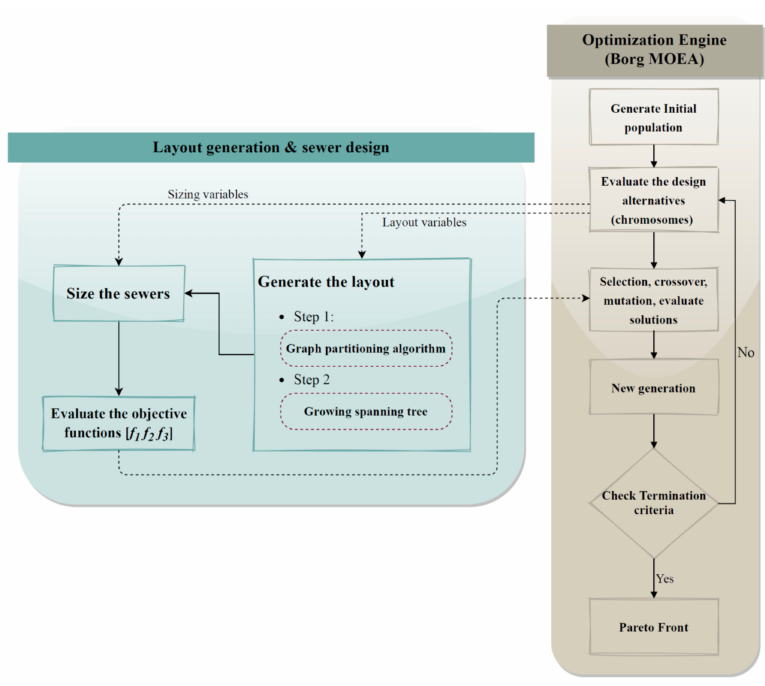
Figure 9. Proposed framework for optimization case